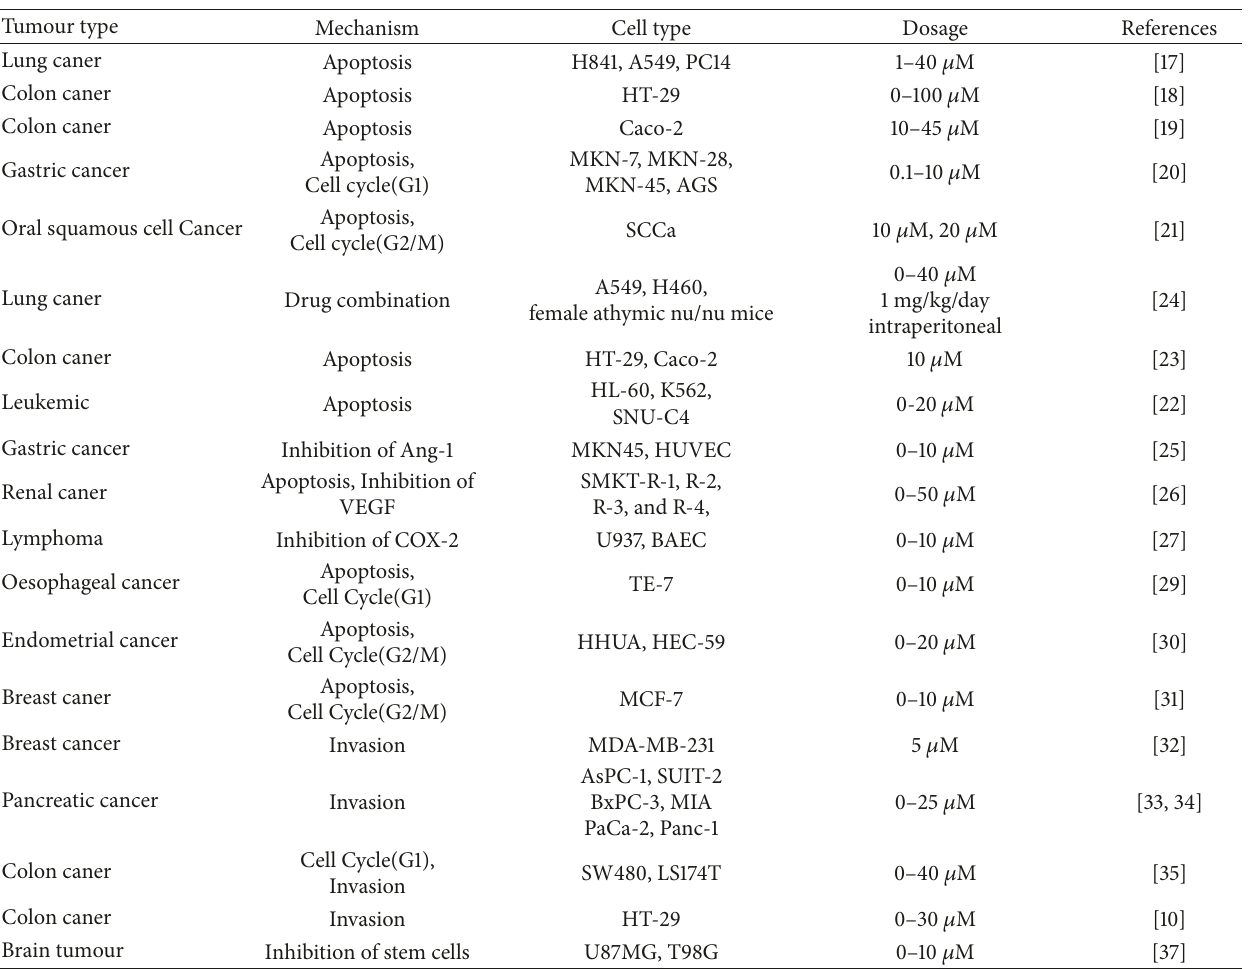
Table 1: Anti-tumour activity of